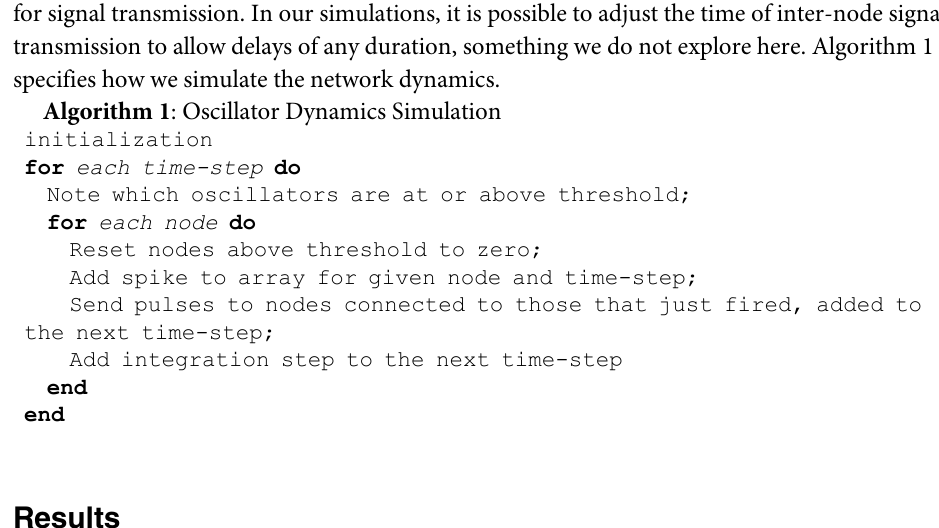
Algorithm 1 : Oscillator Dynamics